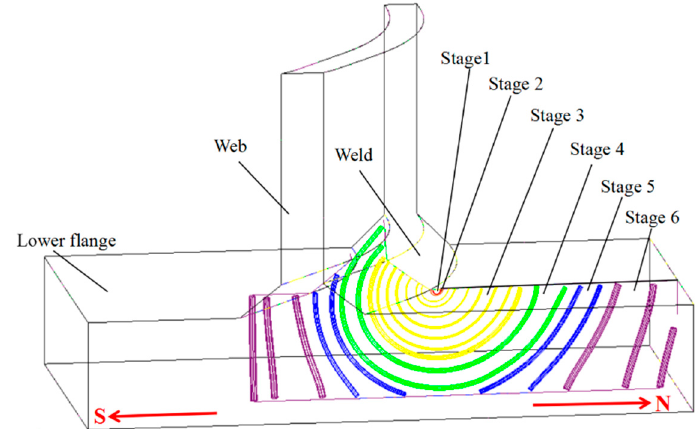
Figure 10. Crack kink in the early stage of the propagation.